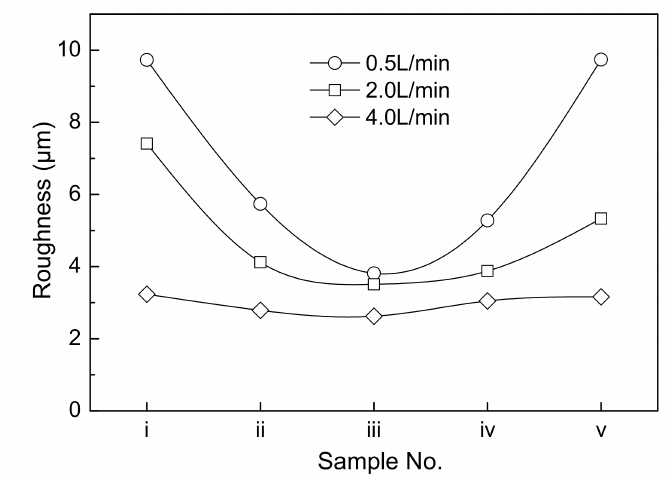
Figure 7. Profile of the surface roughness at different positions of the cathode copper for various electrolyte circulation rates. The position of the single-side jet inlet was at the No. ii nozzle as shown in Figure 1b.